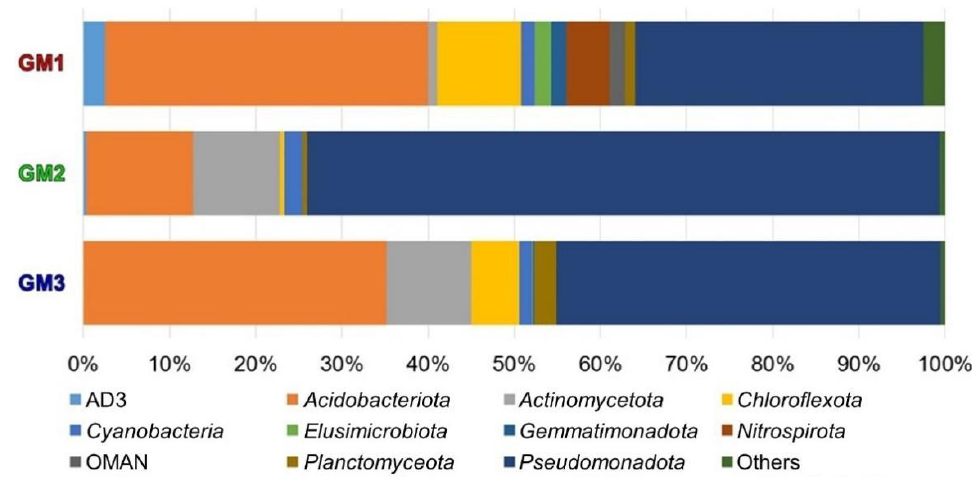
Figure 10. Taxonomic compositions of OTUs from the GM1, GM2, and GM3 speleothems. Nine bacterial phyla and two phylum-level lineages (AD3 and OMAN) were observed with >1% sequence abundance in at least one sample in the MiSeq read data.